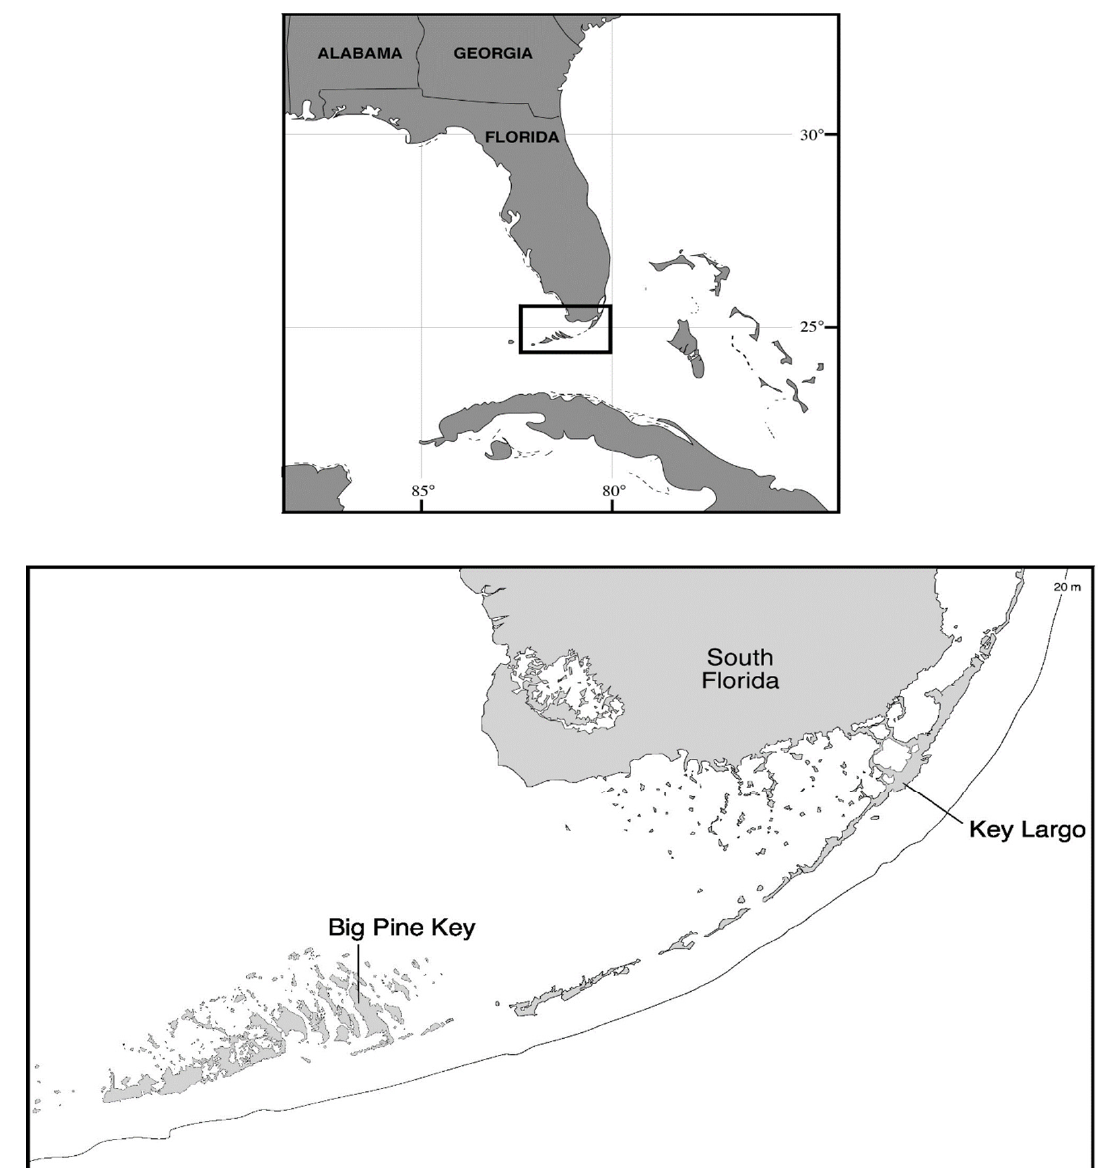
Figure 1. Study site locations.